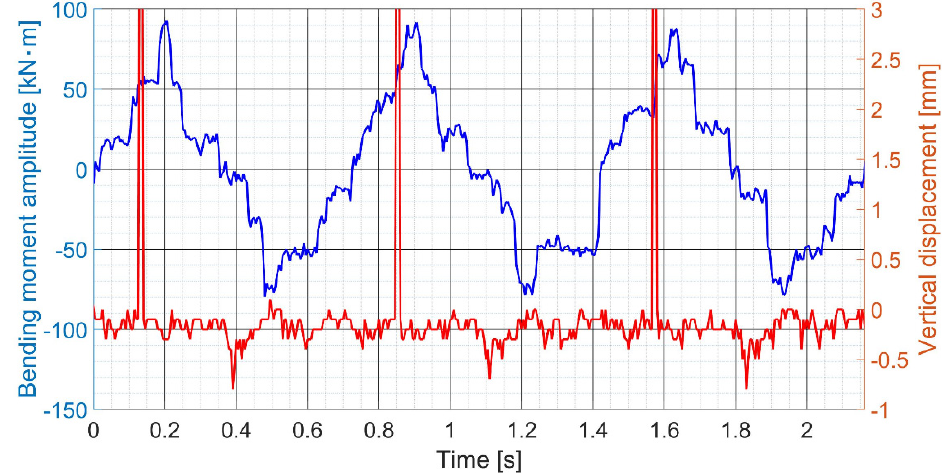
Figure 8. Example of a measured bending moment at the position of the strain gauge and the vertical displacement before processing at the NCR going straight ahead.